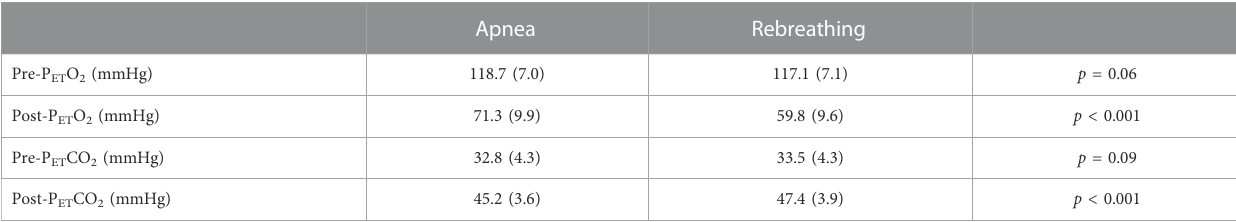
TABLE 2 End-tidal partial pressure of oxygen and carbon dioxide before and after apnea or rebreathing.